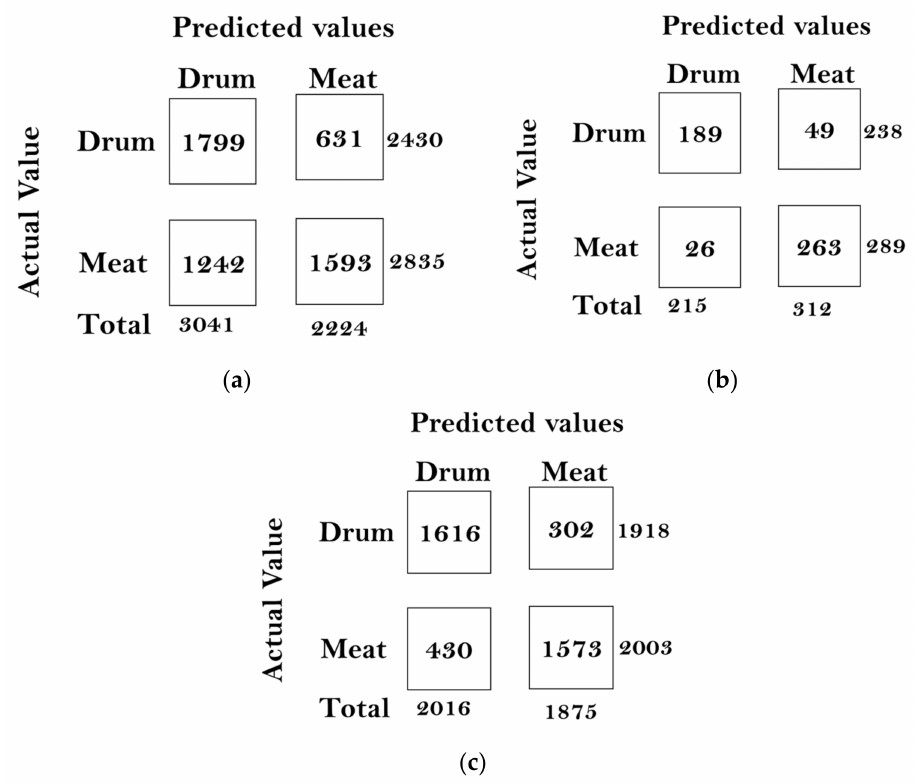
Figure 16. The confusion matrices ( a ) train on Group I and test on Group II, ( b ) Group II, and ( c ) combining Groups I and II.